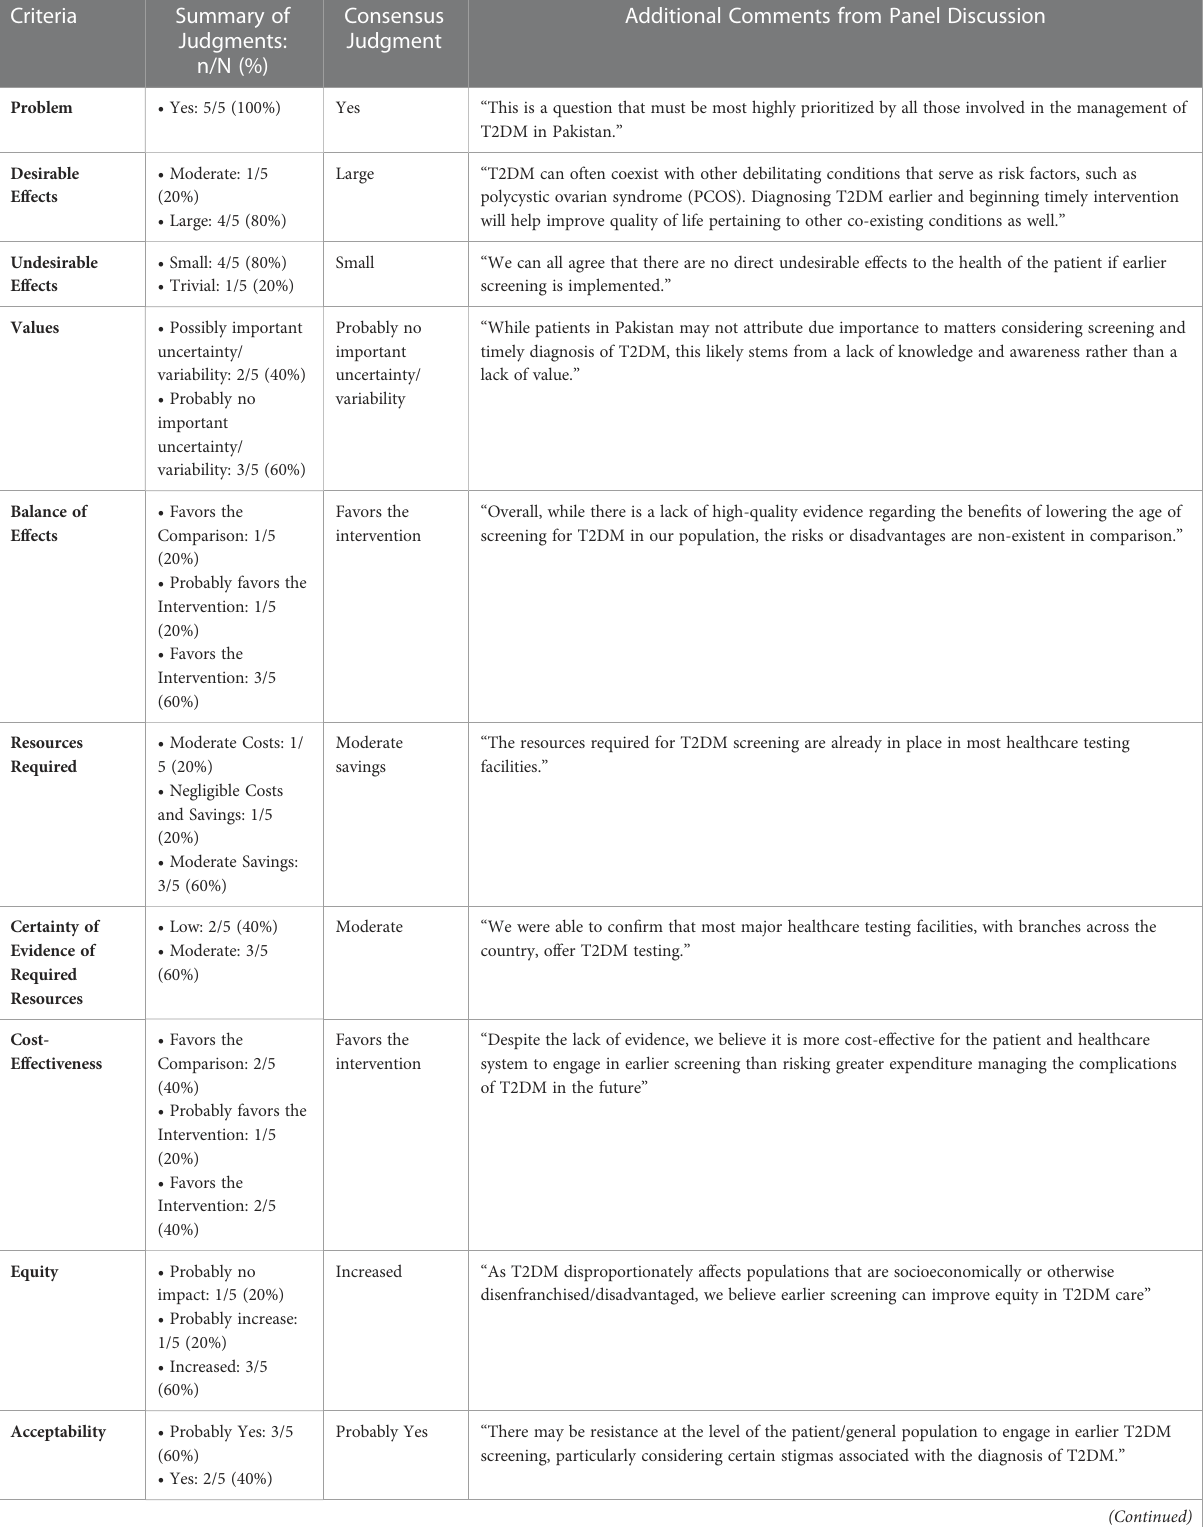
TABLE 1 Summary of